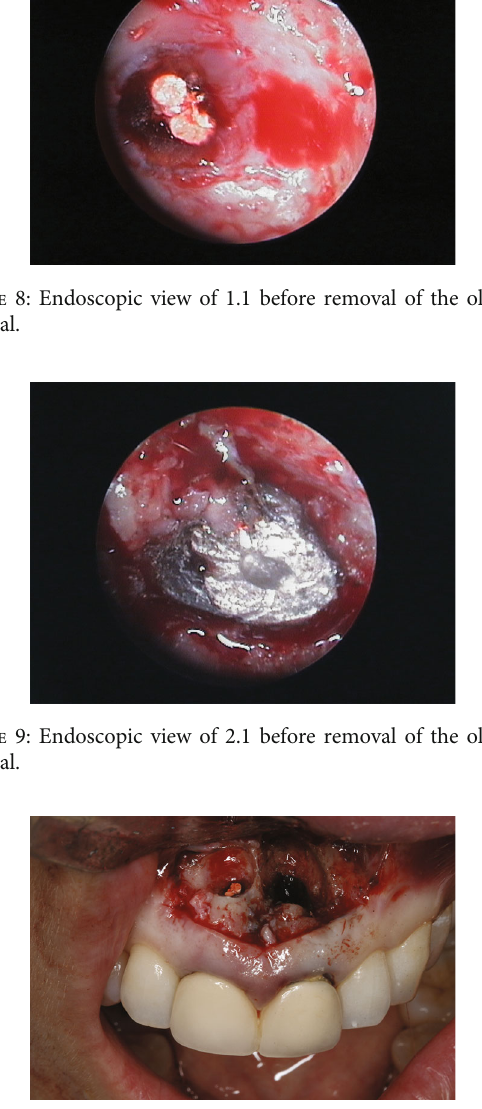
Figure 10: Clinical view of the removal of the old fi ller material of 1.1 and 2.1.